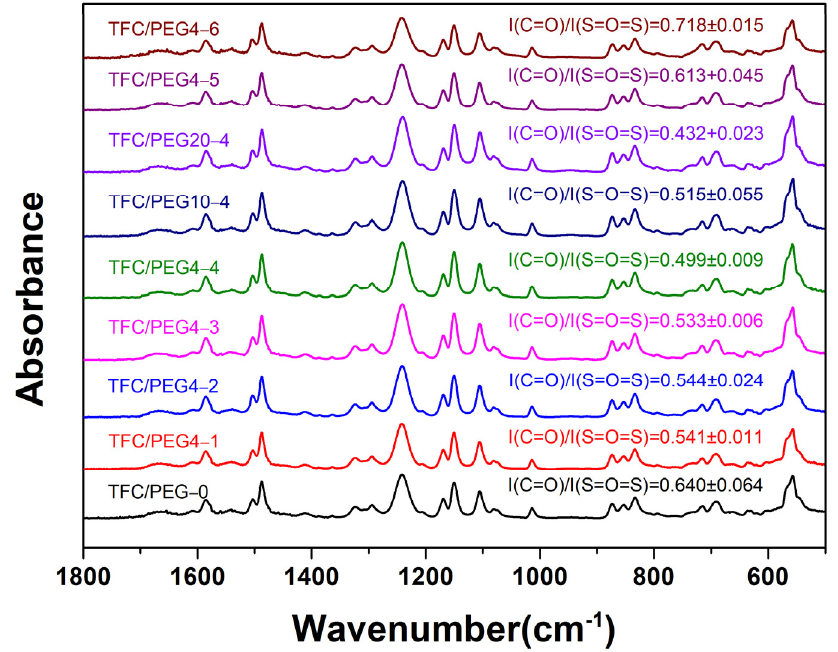
Figure 5. FTIR spectra of PSU/PEG supported TFC-FO membranes.